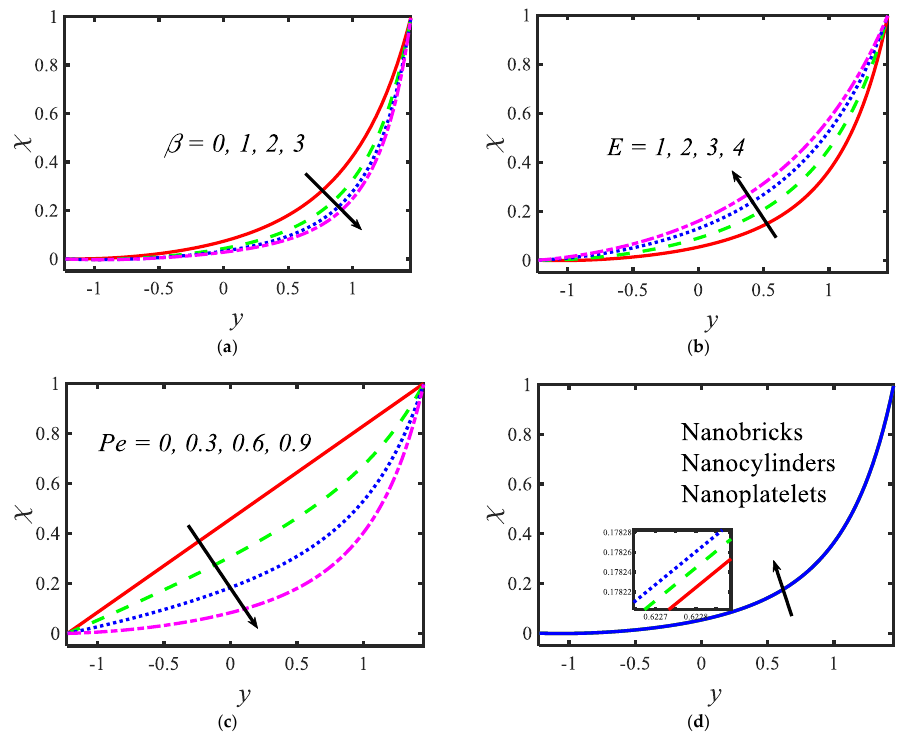
Figure 6. Variations in the motile microorganism profile for ( a ) the temperature ratio parameter, ( b ) activation energy parameter, ( c ) Prandtl number and ( d ) shape factor.